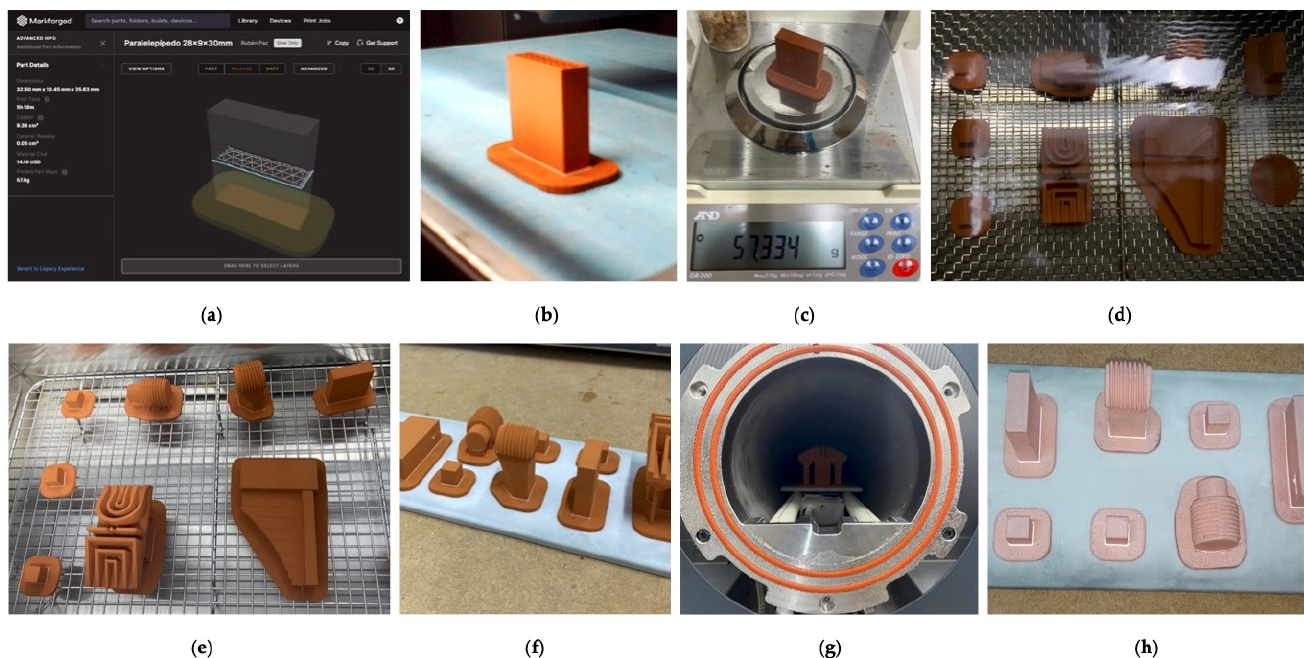
Figure 3. Manufacturing scheme for a batch of parts using ADAM technology: ( a ) Electrode design; ( b ) Printing; ( c ) Initial weight; ( d ) Debinding; ( e ) Drying; ( f ) Pre-sintering; ( g ) Sintering; ( h ) Final parts.